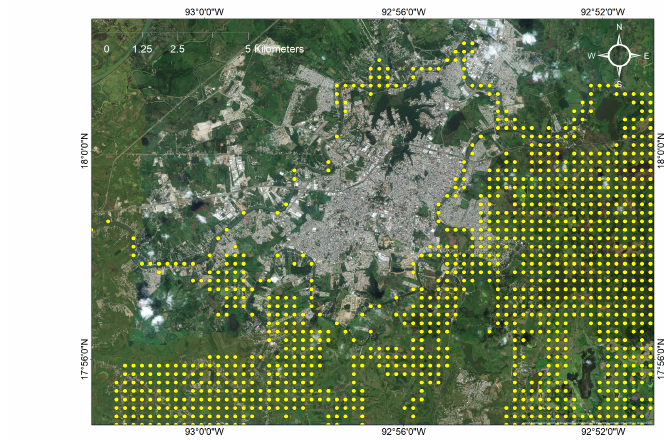
Figure 5. Location of the control points used to evaluate the flood Depth Index (DI).